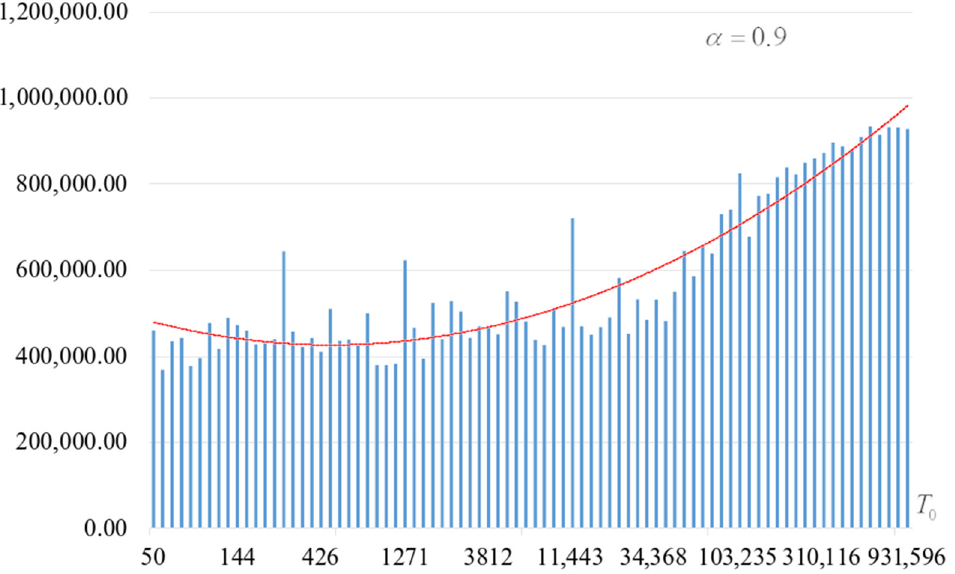
Figure 21. The summary number of the arithmetic mean number of iterations when searching for the target S-box, 𝛼 = 0.9 .